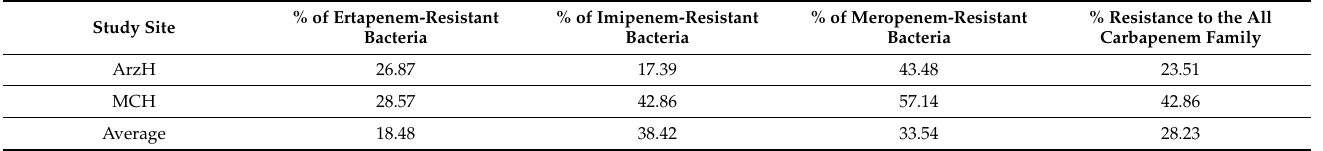
Table 5. Percentage of resistance to the three carbapenems in the two sites ArzH and